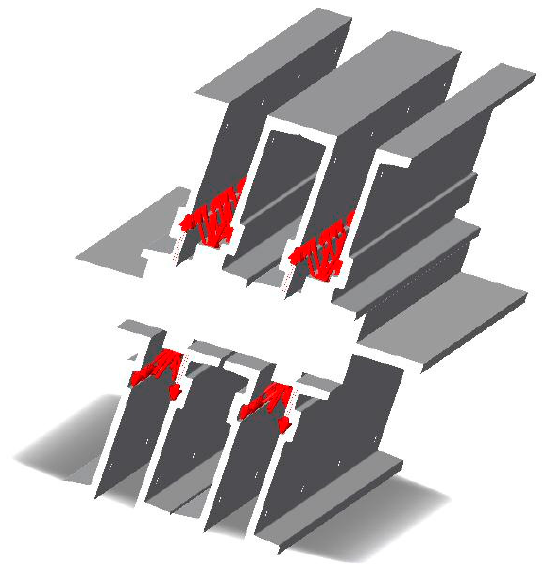
Figure 5. The loads to which are subjected the constructive elements of the belt vulcanization press.